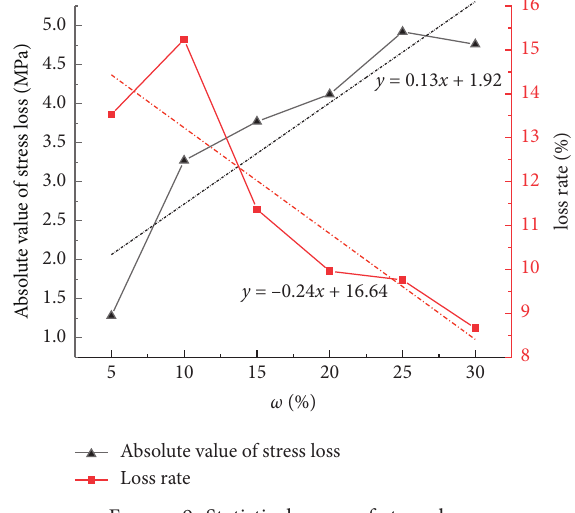
Figure 9: Statistical curve of stress